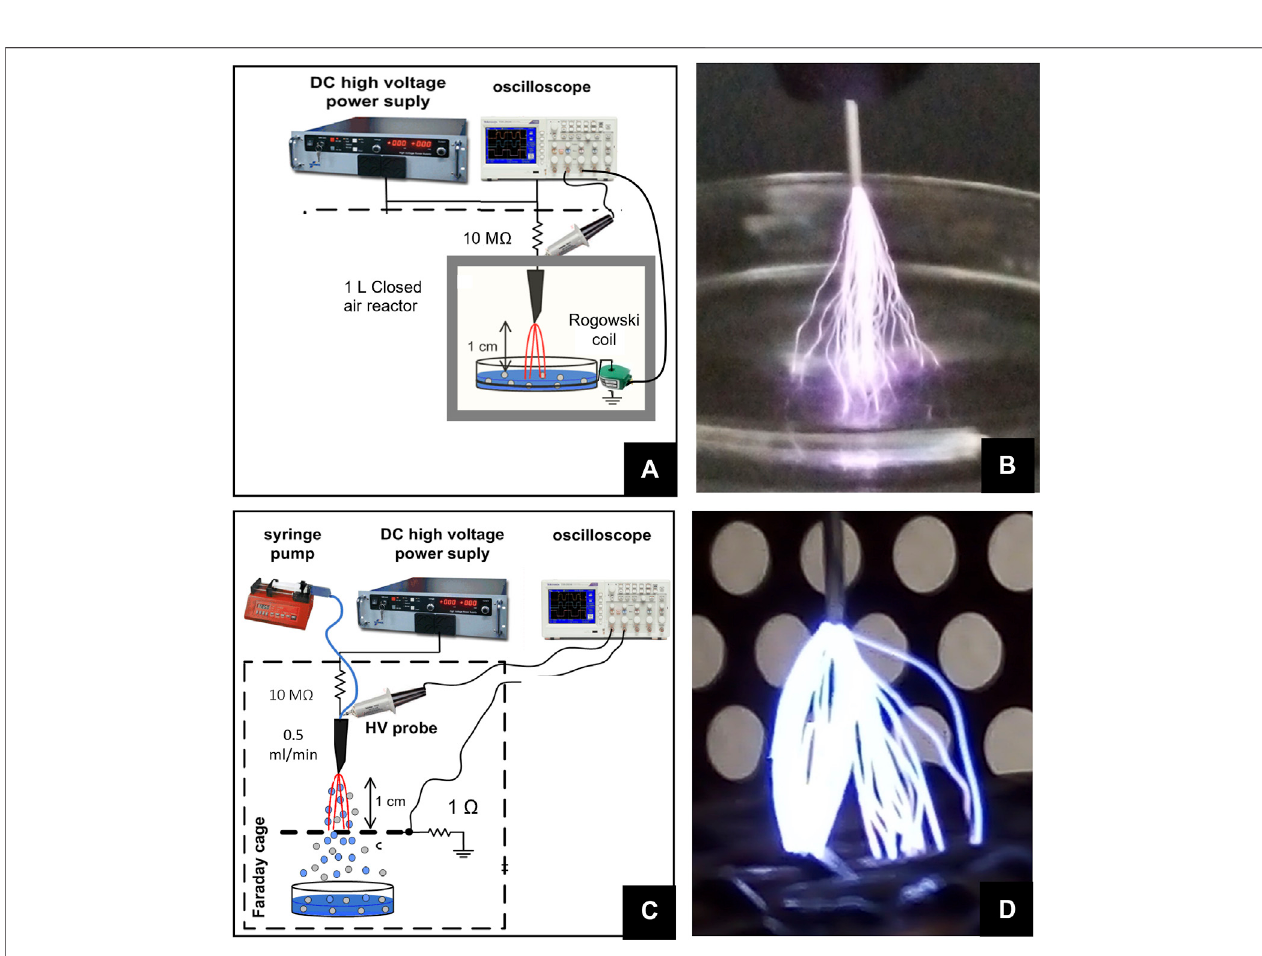
FIGURE2|(A) Photoofatypicaltransientsparkdischargeinthebatch(TS-B)dischargeintheclosedairreactor. (B) ExperimentalsetupofTS-Bclosedairreactor. (C) Photo of a typical transient spark with water electrospray (TS-ES) open air discharge. (D) Photo of a typical TS-ES open air discharge.